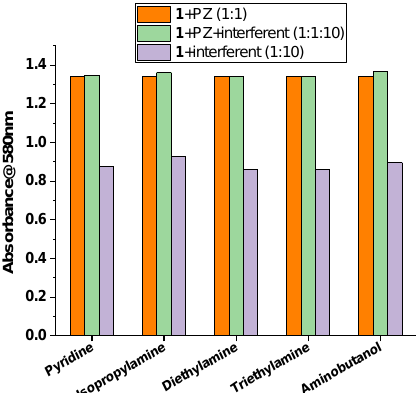
Figure 8. Absorbance of 1 at 580 nm upon the addition of an equimolar amount (15 µ M) of piperazine (orange bars); upon the addition of an equimolar amount (15 µ M) of piperazine with the presence of 10-fold molar excess (150 µ M) of interferent (green bars); upon the addition of 10-fold molar excess (150 µ M) of interferent (violet